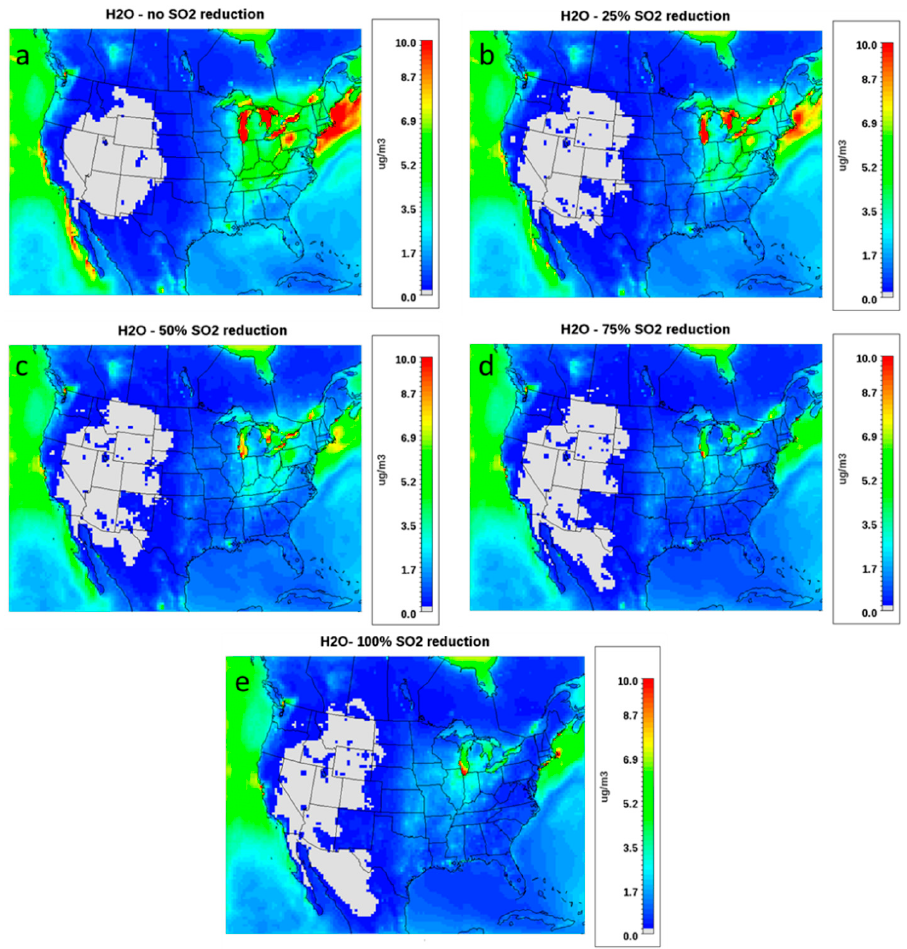
Figure 8. Simulated liquid water content (LWC) fields over the Continental United States (CONUS) for no reductions ( a ), 25% ( b ), 50% ( c ), 75% ( d ) and 100% ( e ) SO 2 emission reductions.